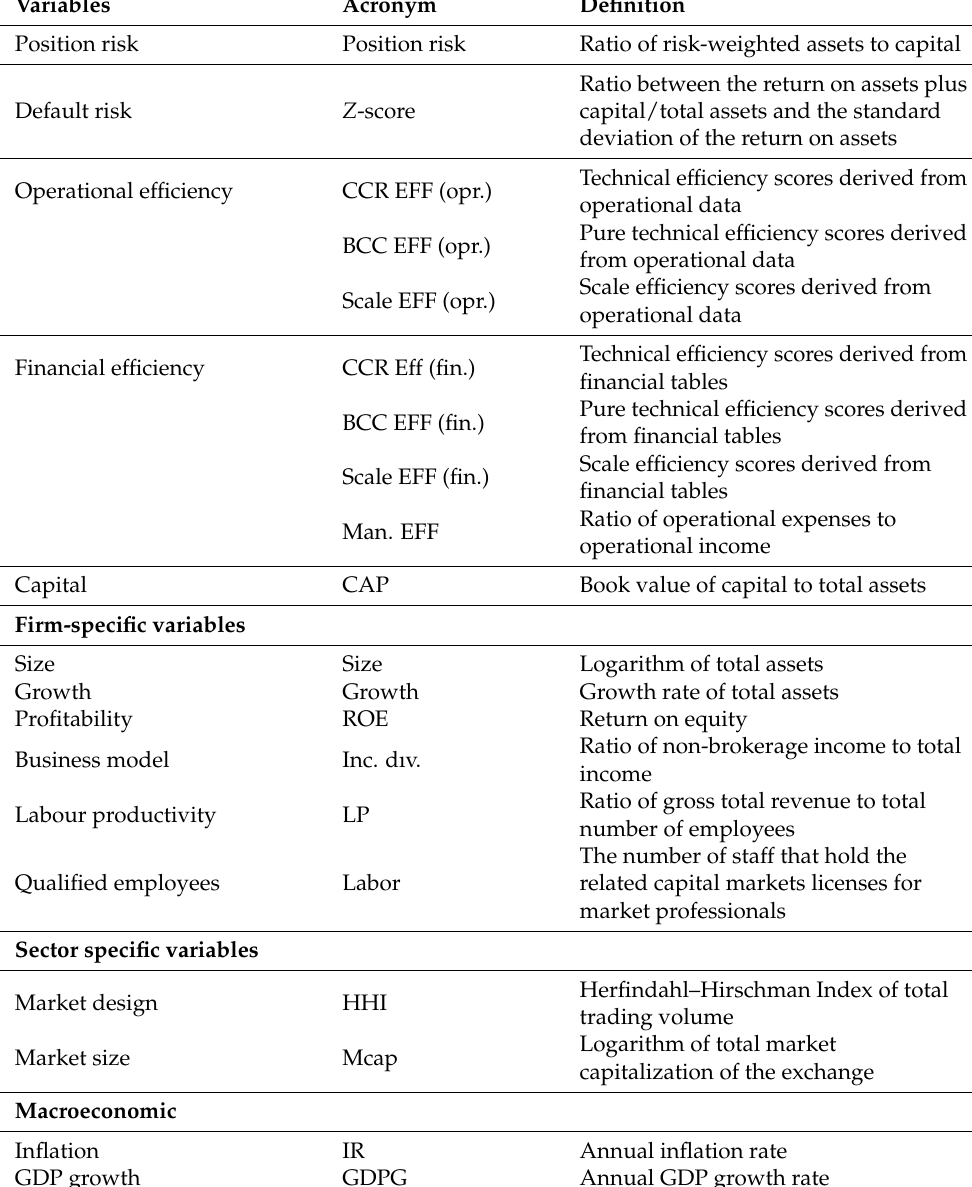
Table 5. Description of variables used in the